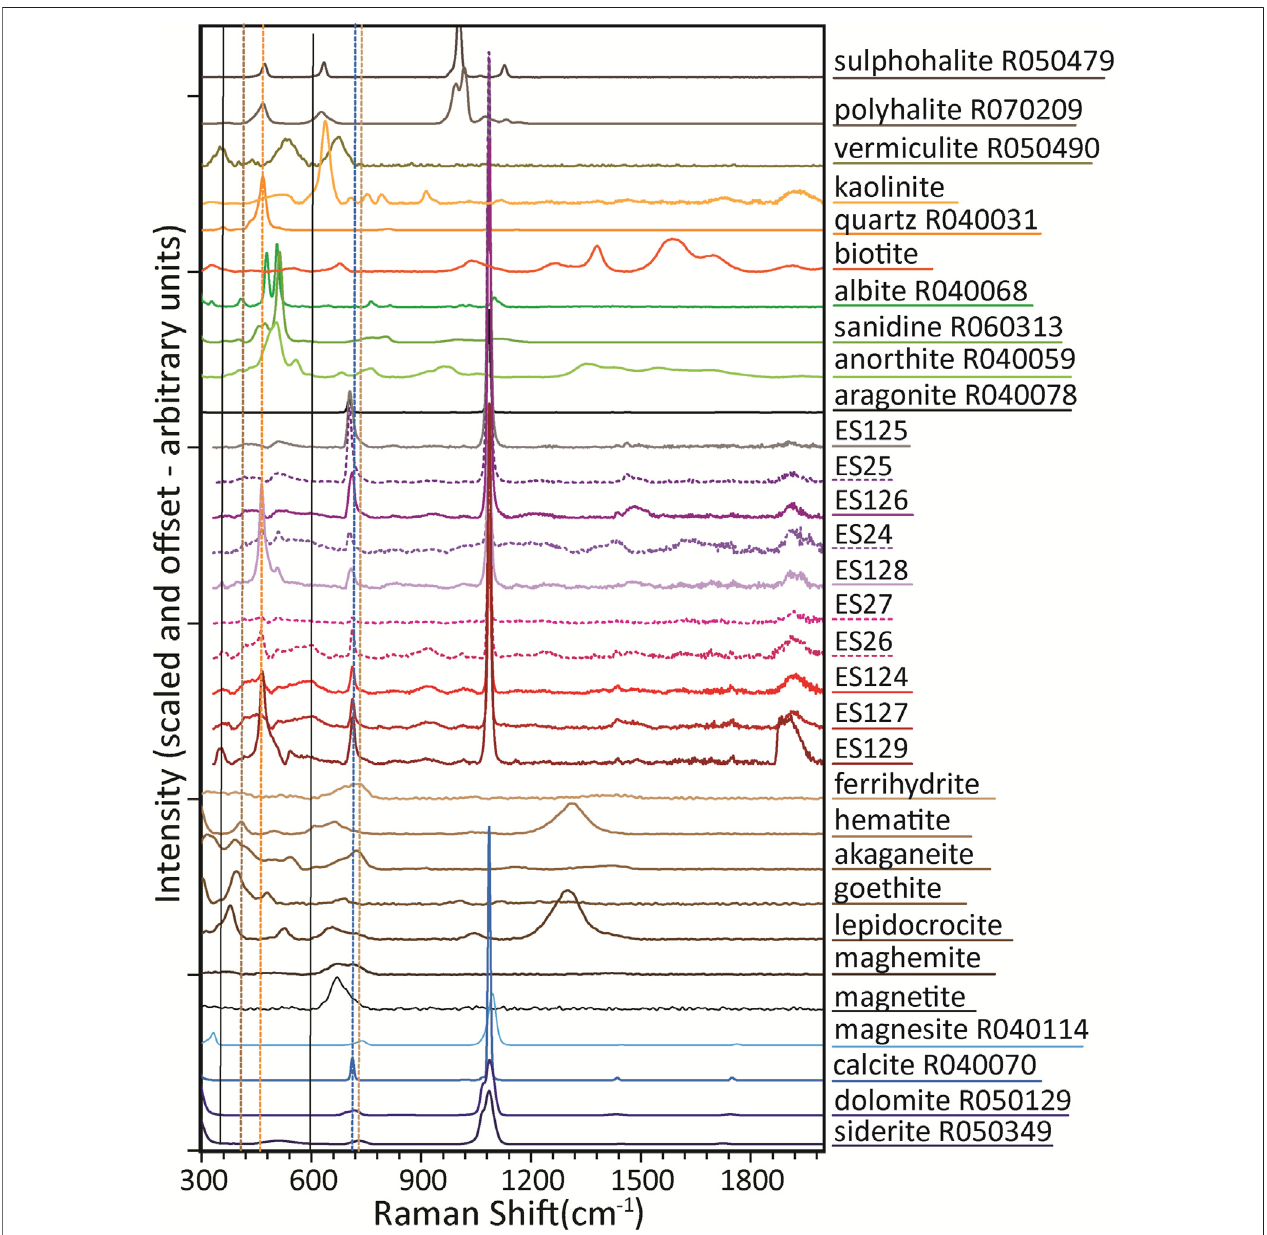
FIGURE 5 | Raman spectra of Blood Falls samples along with Raman spectra of representative identi fi ed, possible tracephases, and several conjectured phases. Referencespectraareasin Figure4 ,withtheexceptionofbiotiteandkaolinite,whichareMtHolyokelibrarysamplesthataredifferentfromthoseforwhichIRdataexist.